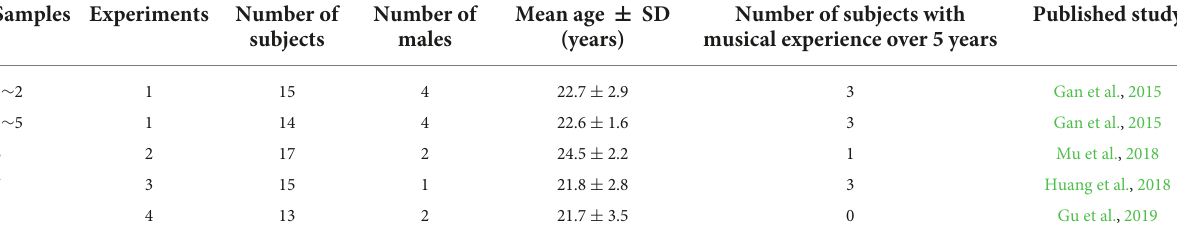
TABLE 1 Subjects’ information of the small sample-size data